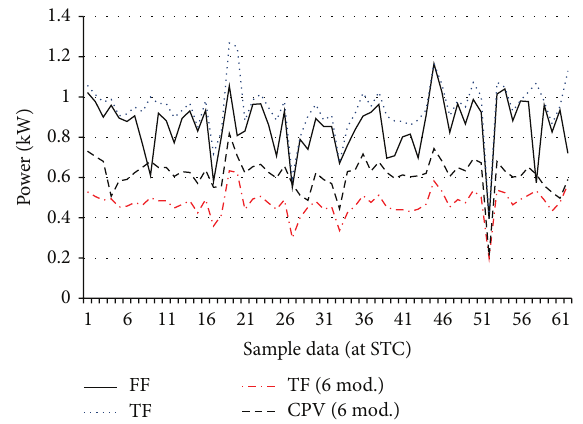
Figure 7: Power generation from each individual PV generator at STC conditions.